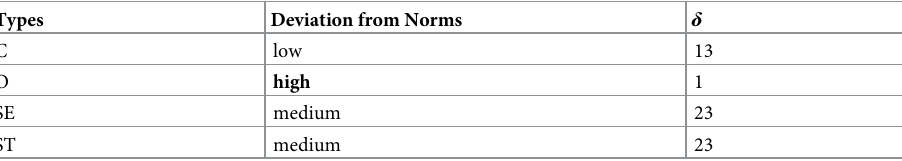
Table 2. Probability to deviate from